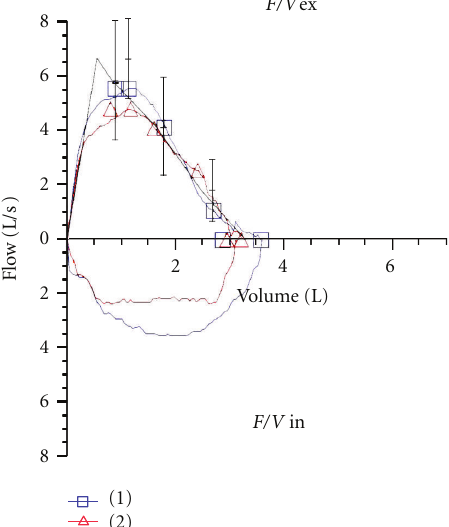
Figure 1: Flow volume loop before (1) and after (2) cardiopulmonary exercise testing (when the patient became symptomatic). An evident flattening of the inspiratory curve is seen, suggesting a variable extrathoracic obstruction.